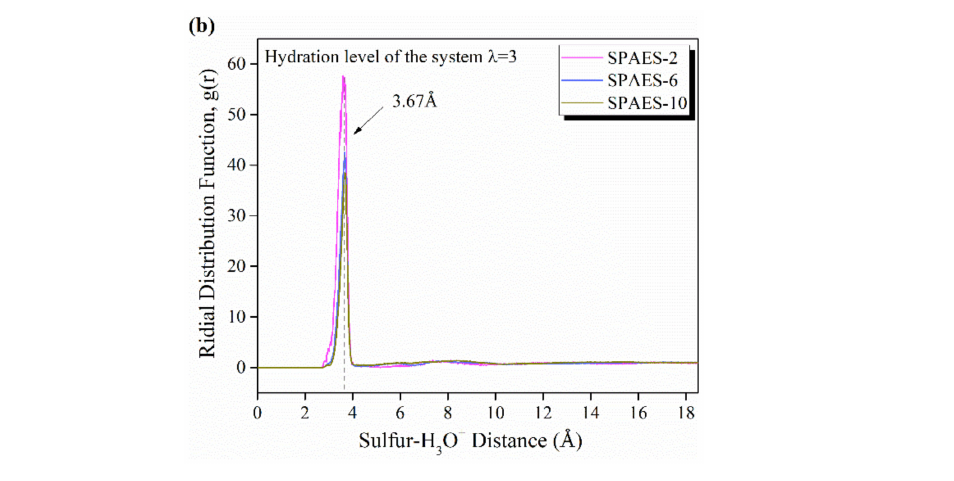
Figure 6. RDFs of ( a ) sulfur–water molecules and ( b ) sulfur–hydronium ions for the membrane with various lengths of side chains at hydration level of λ = 3.